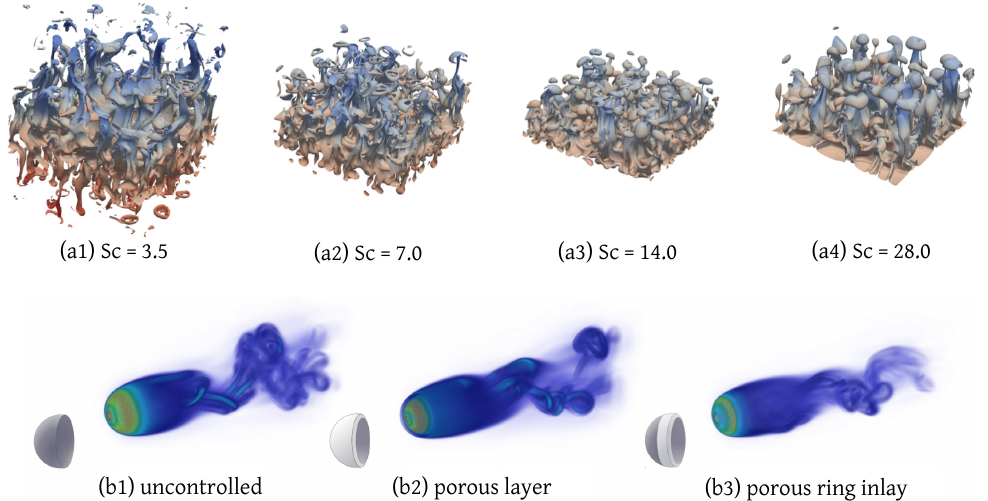
Figure 11. From a1 to a4 (case #8) Courtesy of Keck [141] Sediment isocontours showing moving fingers (downward w.r.t interface) at different Schmidt numbers. From b1 to b3 (case #9) Effect of porous-coating configuration on the wake of flow past a hemisphere at Re D =